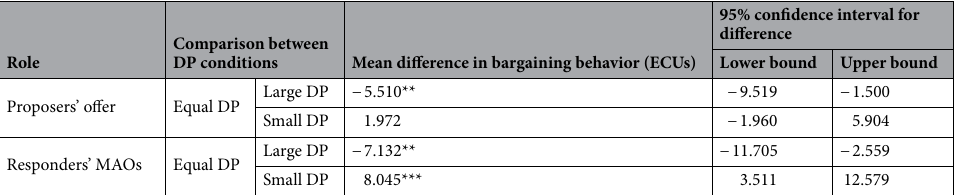
Table 2. Comparison of bargaining behavior across power conditions. * p < 0.05. ** p < 0.05. *** p < 0.001.